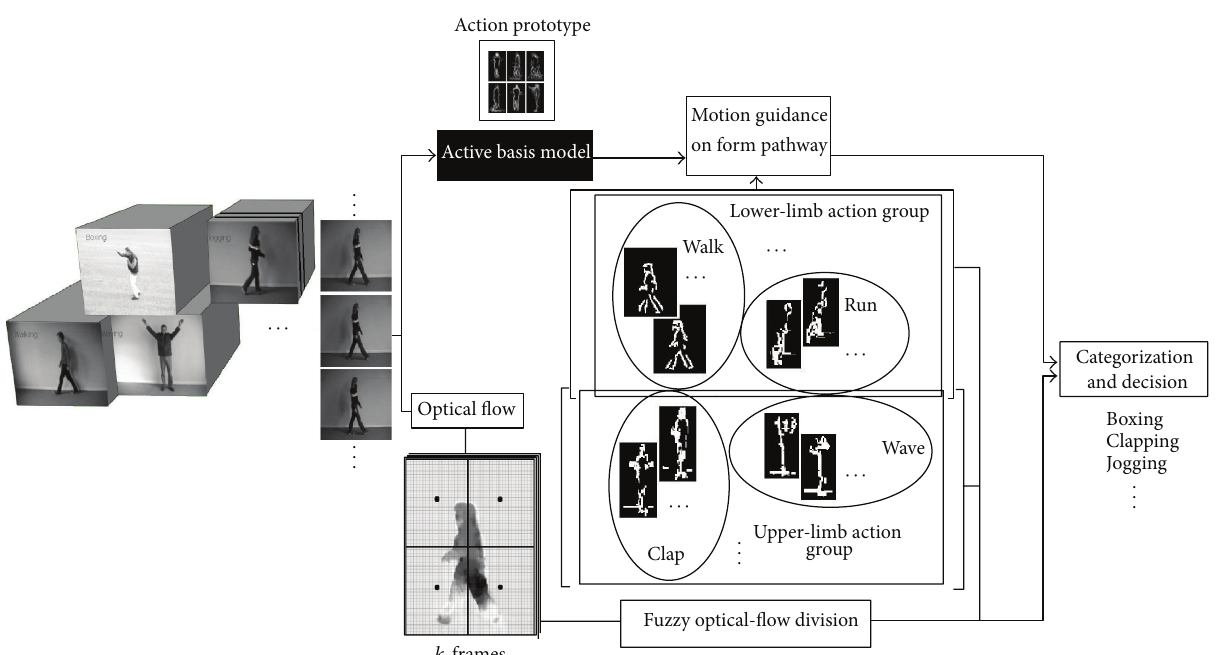
Figure 1: The figure reveals the flowchart of our algorithm regarding human action recognition. The flowchart presenting the hierarchical model in terms of theoretical and computation for combination of the form information and motion information is shown. A supervised Gaborbasedobjectrecognitionmethod,ABM,givesthispropertytohavehumanobjectandcomputationoftheformdataanditscombination with optical flow information, motion information, creates interaction between the pathways.